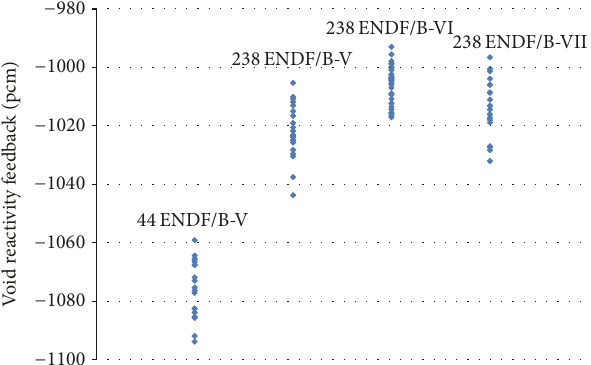
Figure 7: Scale uncertainty analysis results.